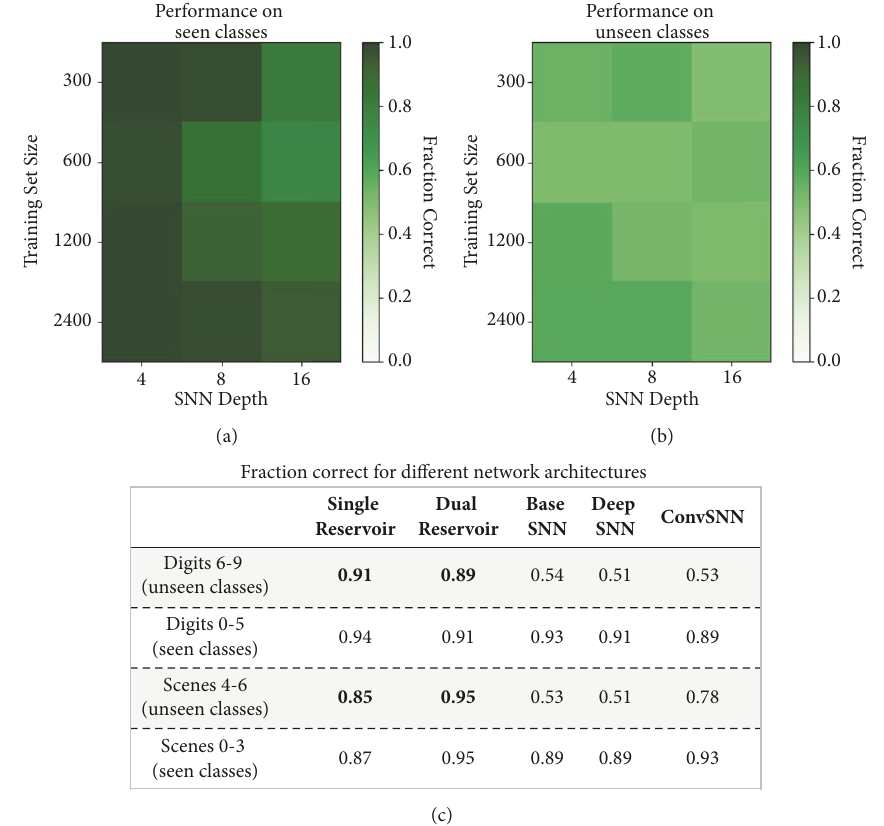
Figure 7: SNN perceptron performance on trained (seen) classes (a) and test (unseen) classes (b) of MNIST data as a function of training datasetsizeandSNNperceptrondepth.(c)Classificationaccuracy(fractioncorrect)ofthesingleanddualreservoir,baseSNN,deepSNN,and convSNN on seen (trained) classes and unseen (test) classes, on (1) identifying rotation transformation in MNIST images; and (2) identifying similar visual scenes from a moving camera. Training size: 500 images; testing size: 500